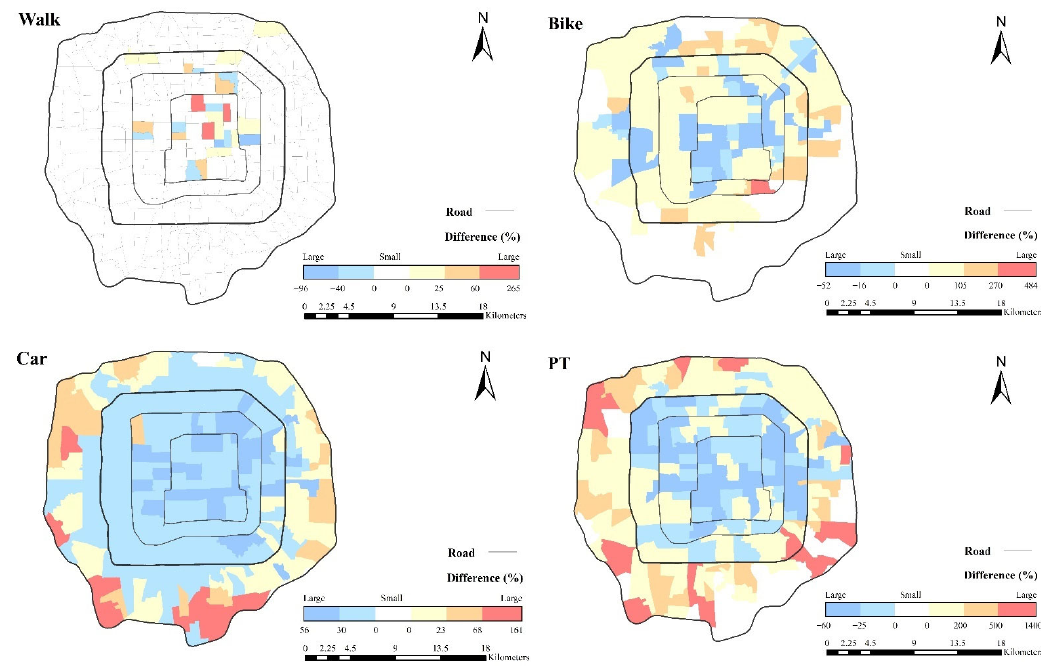
Figure 12. The difference under four travel modes by the PM2SFCA method and E2SFCA